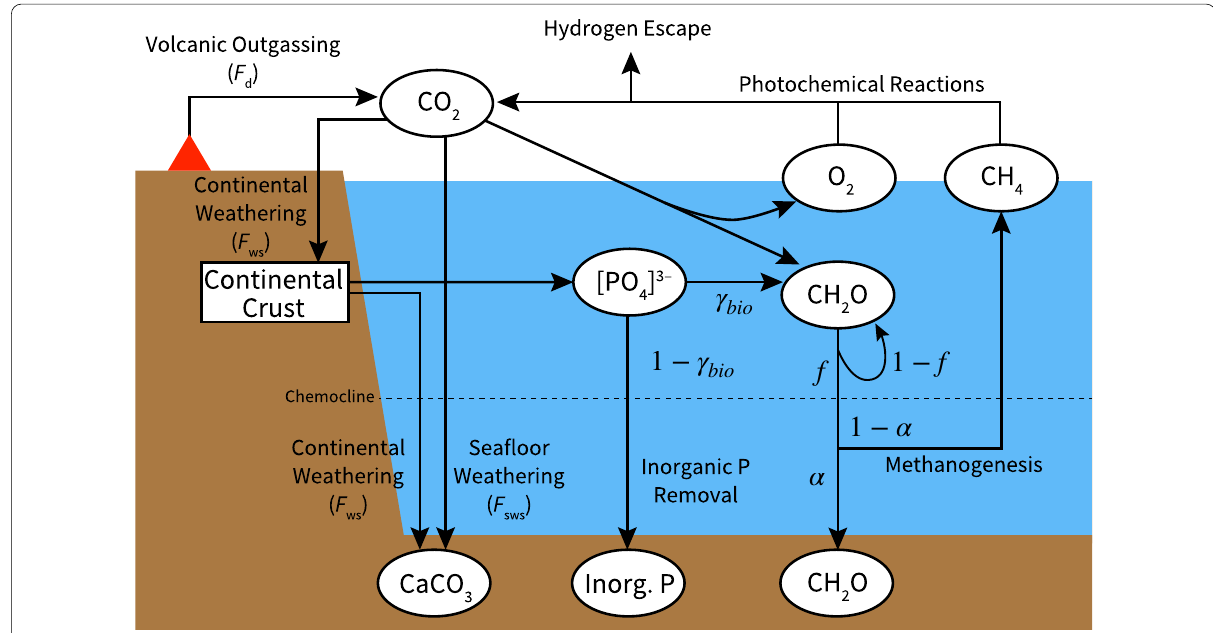
Fig. 1 Schematic diagram of the simplified steady-state ocean box model. Arrows represent a net chemical